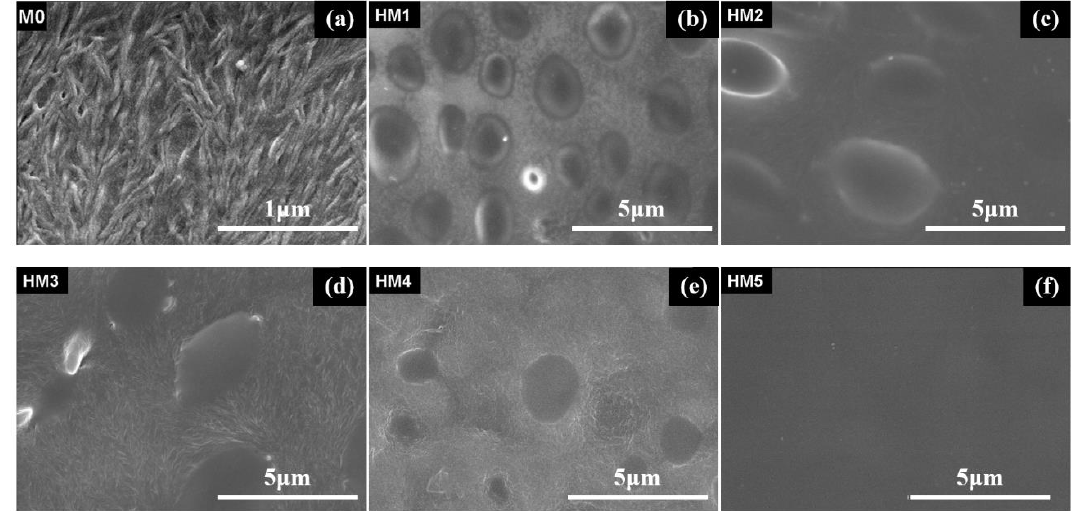
Figure 3. SEM images of the surfaces of the blank membrane and organic–inorganic hybrid ion channel membranes: ( a ) M0; ( b ) HM1; ( c ) HM2; ( d ) HM3; ( e ) HM4; ( f ) HM5.